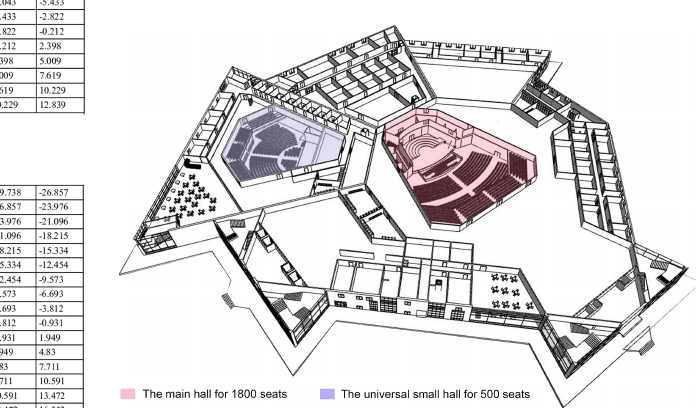
Figure 16: The project of the concert hall with the use of the conoid surfaces